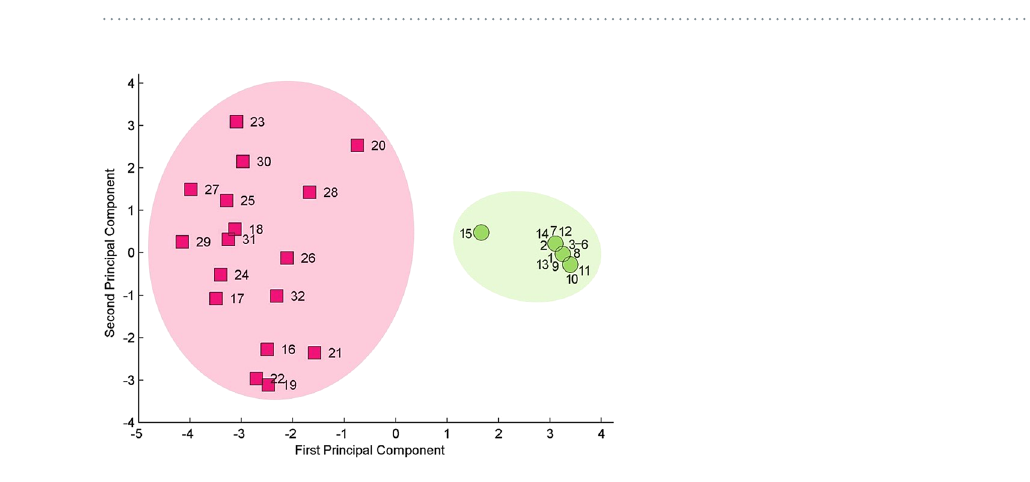
Figure 1. Scatterplot of the scores for the first (PC1) and second (PC2) principal components based on the principal component analysis (PCA). The data were subjected to z -score standardization prior to analysis. Red squares represent Fargesia species, and green circles represent Thamnocalamus species. Please see Table 1 for